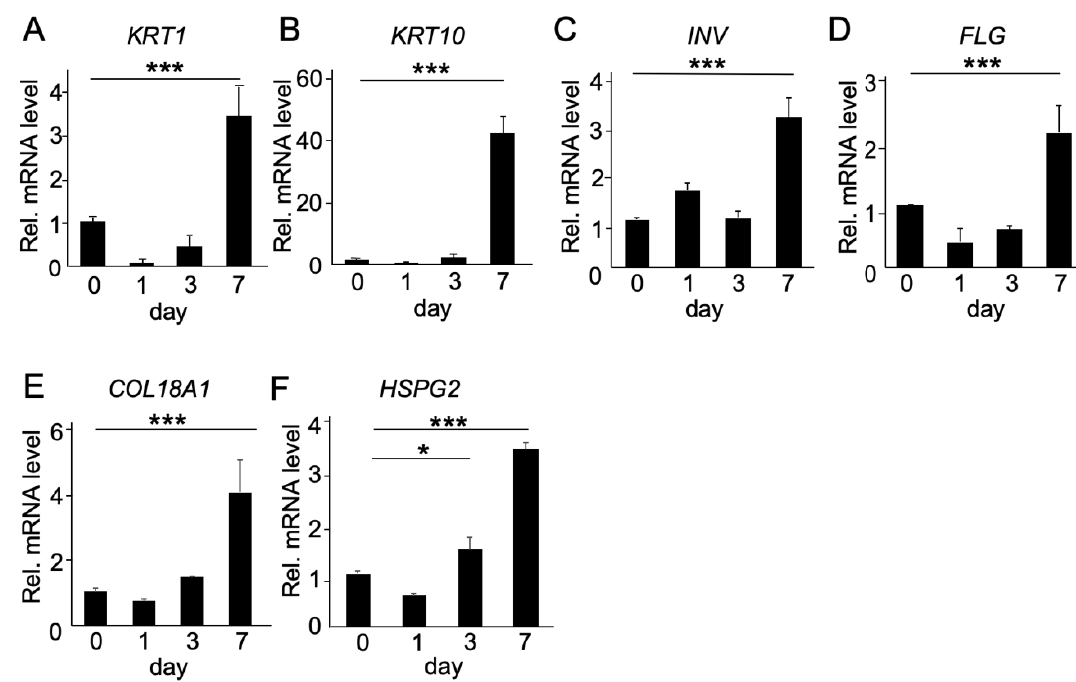
Figure 2. Quantitative analysis of gene expression of keratinization-associated genes, and the heparan sulfate proteoglycans, COL18A1 and HSPG2 , during epithelial keratinization in vitro. TR146 cells were cultured onto a ThinCert cell culture insert (3D culture). Samples were collected after each time-point (0, 1, 3, 7 days) and the gene expression levels of KRT1 , KRT10 , INV , FLG , COL18A1 , and HSPG2 were analyzed by real-time RT-PCR and normalized with levels of S29 ribosome RNA. Note that the mRNA expression levels of most genes KRT1 ( A ), KRT10 ( B ), INV ( C ), FLG ( D ), COL18A1 ( E ), and HSPG2 ( F ) increased significantly after 7 days of culture. Bars represent the mean values and standard deviation ( +/ − SD) ( n = 3). * p < 0.05, *** p < 0.001 (ANOVA, Turkey multiple comparison test).